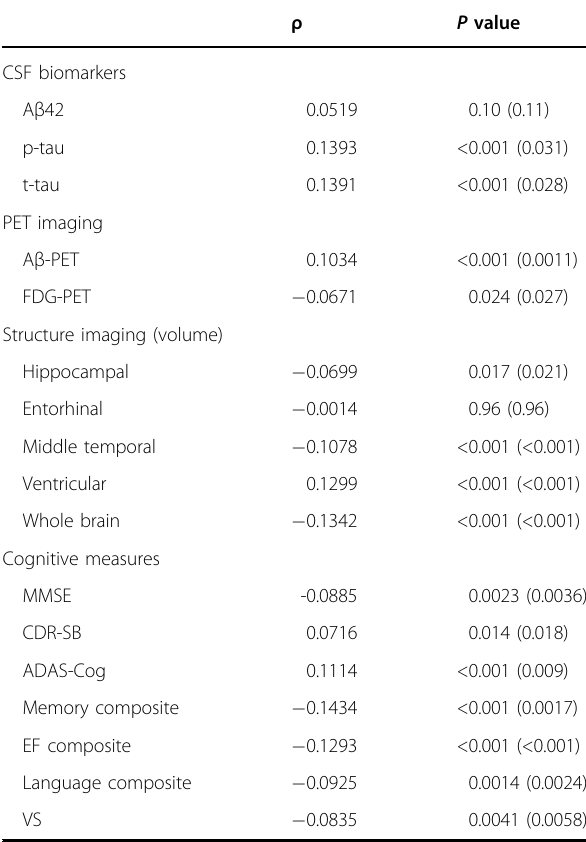
Table 3 Correlations of concurrent changes in plasma p- tau181 and other